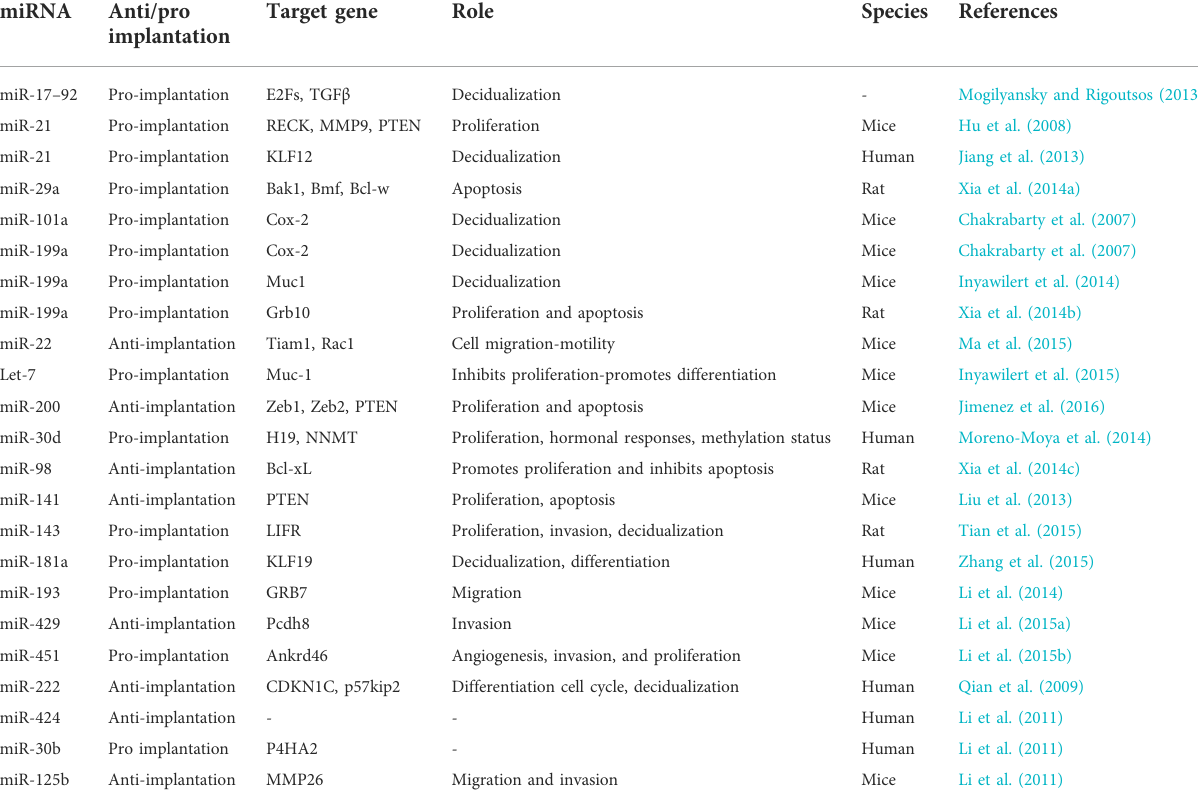
TABLE 2 Endometrial miRNAs and implantation.